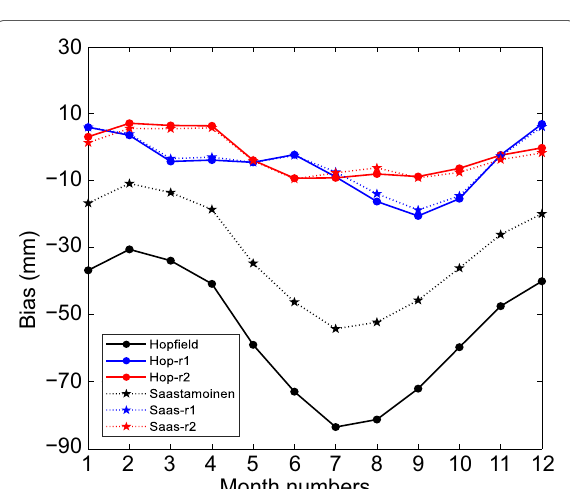
Fig. 7 Monthly mean bias of the stations for six models